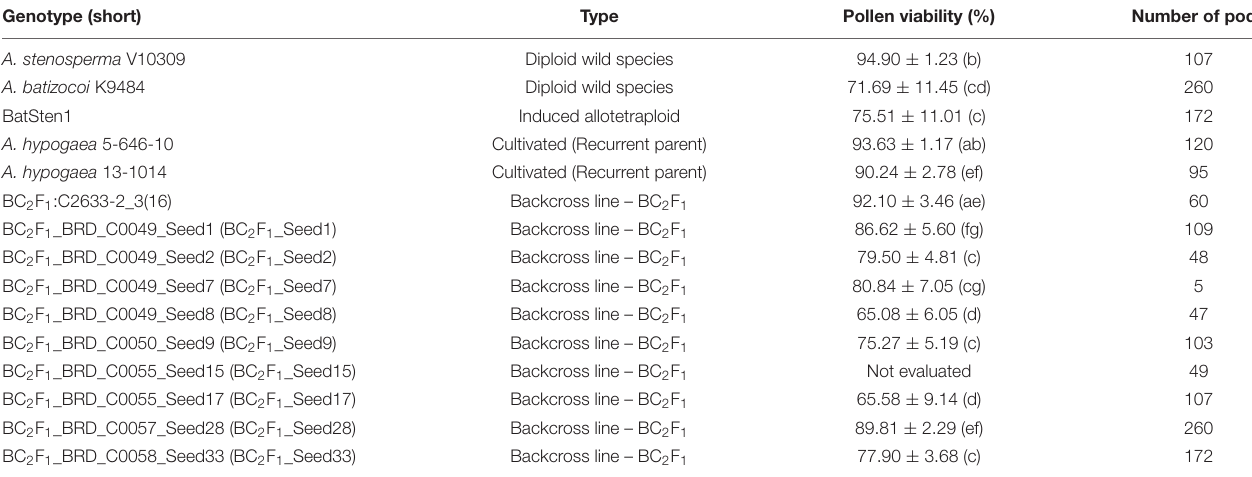
TABLE 3 | Average and standard deviation for pollen viability (%) and the number of pods quantified in BC 2 F 1 s lines and controls. Genotype